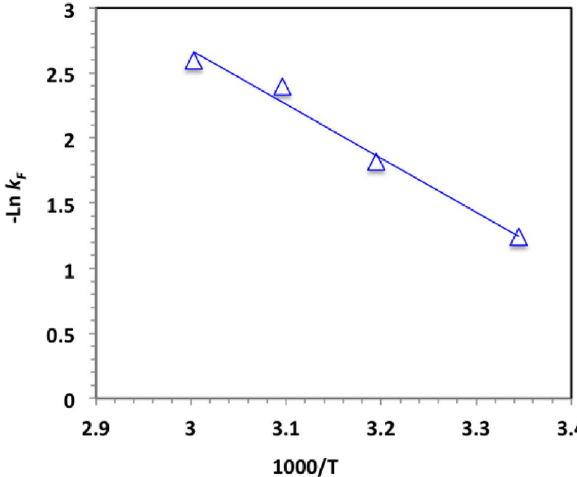
Fig. 10 Plot of ln k F versus 1000/T for the Synozol Blue oxidation reaction (solid lines represent least-squares fitting)